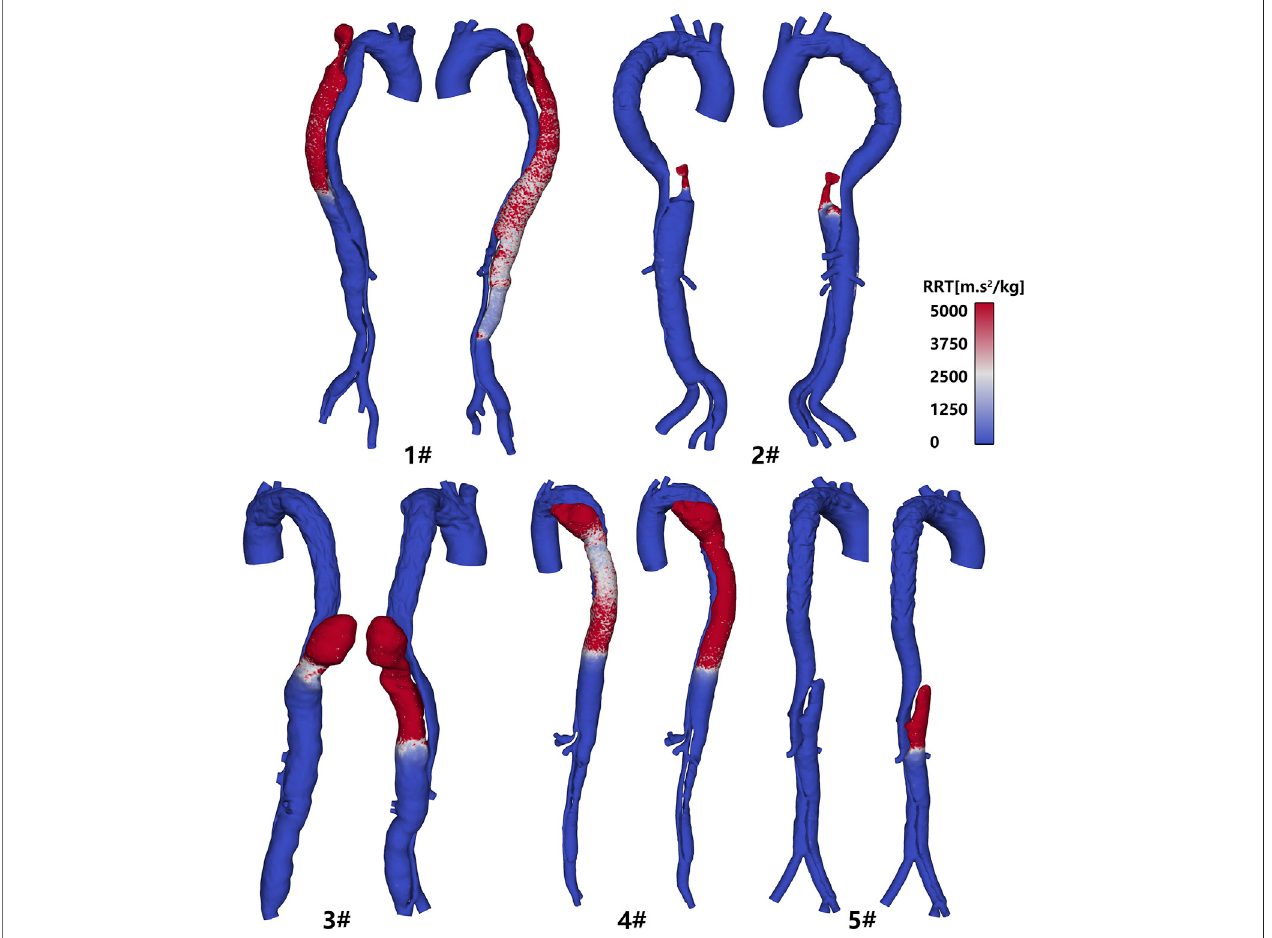
FIGURE5| Distributionoftherelativeresidencetimeineachcomputationalmodel.Ineachcase,thepost-TEVARmodelisontheleft,andthemodi fi edmodelison the right.